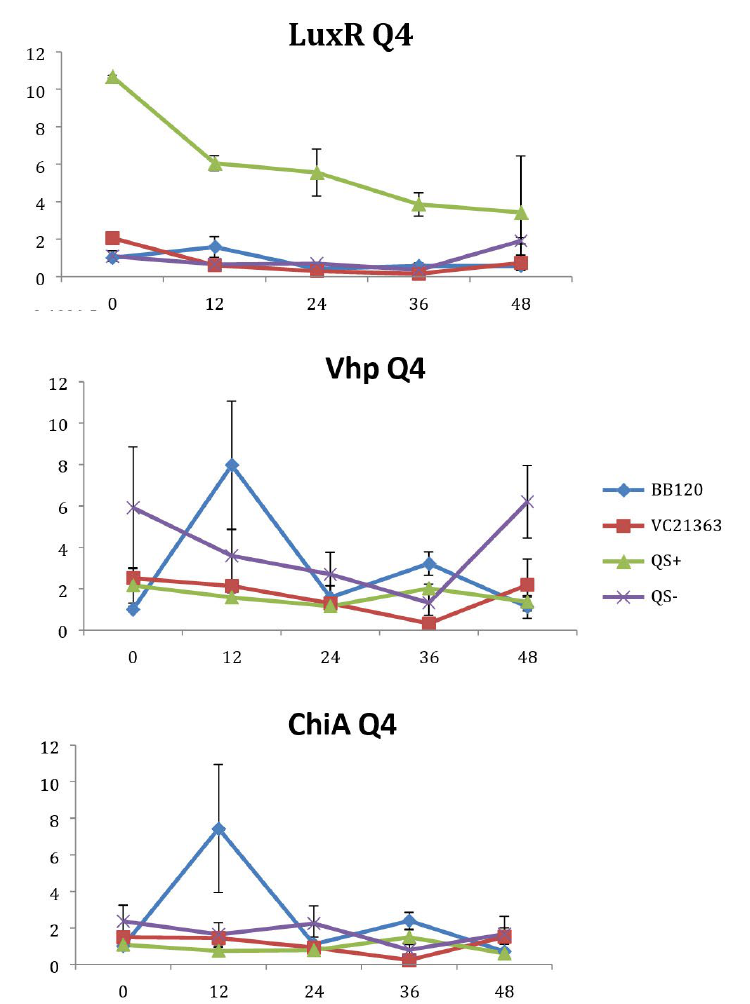
Fig. 4. Relative gene expression levels of luxR, vhp and chiA over a 48h period in treatment Skeletonema marinoi =1x10 4 cells ml -1 , and Vibrio =10 4 cells ml -1 . Y-axis= Relative expression to RpoA , X-axis= Time elapsed (hr). Error bars represent standard error of